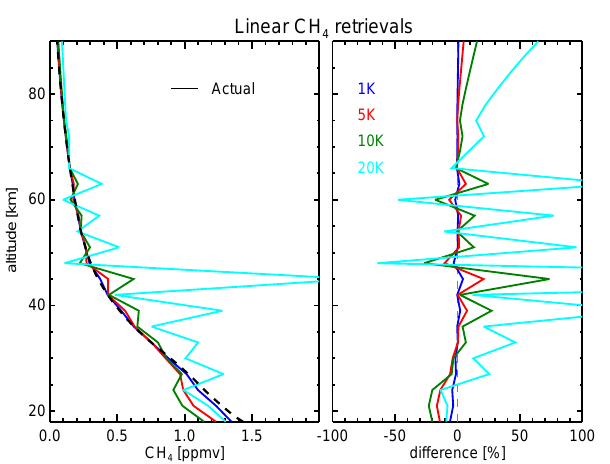
◦ ◦ ◦ , 30 and 20 latitude bin profiles for the MIPAS MA